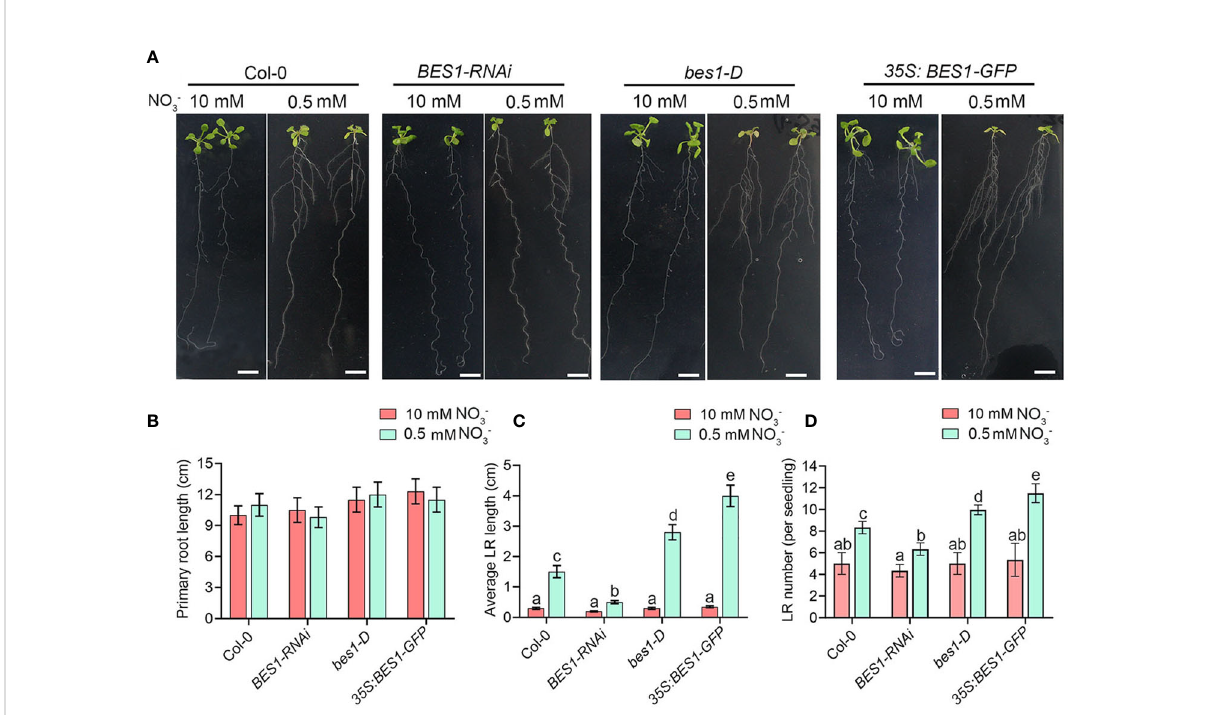
FIGURE 2 BES1 promotes the lateral root growth and development at LN. (A) Seedling phenotypes of Col-0, BES1-RNAi , bes1-D and 35S:BES1-GFP . 5- day-old seedlings were precultured on medium containing 10 mM NO 3- and then transferred to HN medium or LN medium for another 9 days for quanti fi cation of primary root length (B) , average lateral root length (C) , and lateral root number (D) . Error bars indicate the s.d. (n = 10-15). Different Lowercase letters above the bars indicate statistically signi fi cant differences between samples (p < 0.05, two-way ANOVA). Scale bars,